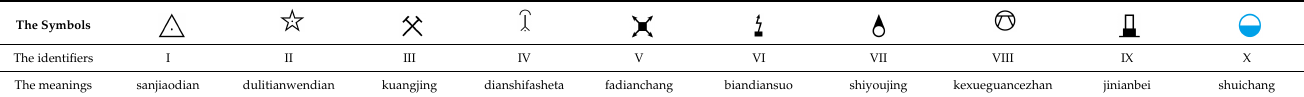
Table 1. The symbols and their identifiers.